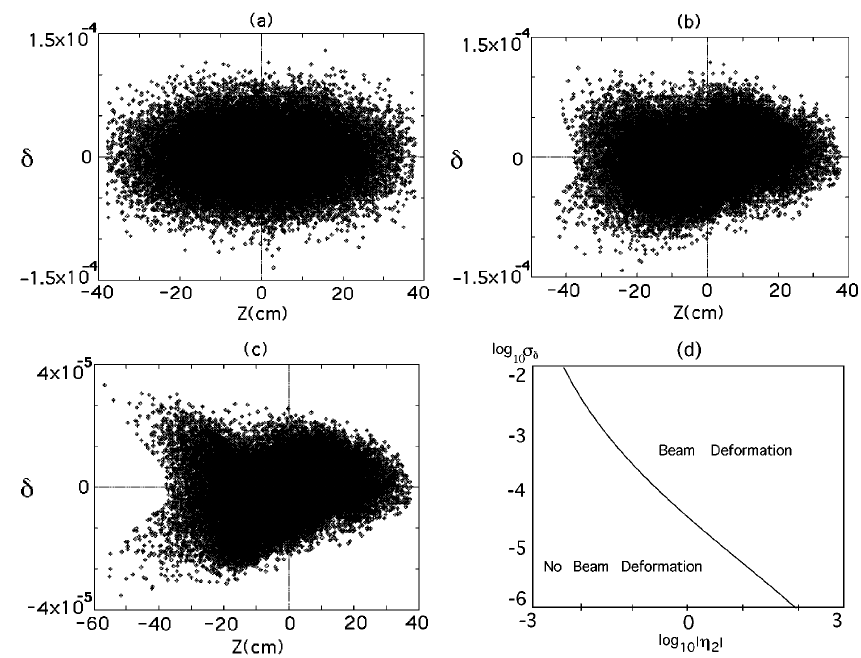
FIG. 9. The longitudinal phase space after 1000 turns for (a) h (cid:50) (cid:173) (cid:51) , (b) h (cid:50) (cid:173) (cid:53)(cid:48) , and (c) h (cid:50) (cid:173) (cid:49)(cid:48)(cid:48) . Two cavities are used to compensate for bunch wake. (d) shows beam dynamics in the s d and h (cid:51) parameter space. The right upper parameter space shows the beam streaming of positive or negative (cid:122) direction, depending on the sign of h (cid:50) . Here, h (cid:49) (cid:173) 2 (cid:49) 3 (cid:49)(cid:48) 2 (cid:54) , h (cid:51) (cid:173) (cid:48) , j (cid:173) (cid:48)(cid:46)(cid:49) V . s d (cid:173) (cid:51) 3 (cid:49)(cid:48) 2 (cid:53) , and j (cid:90) k (cid:110) 051001-8